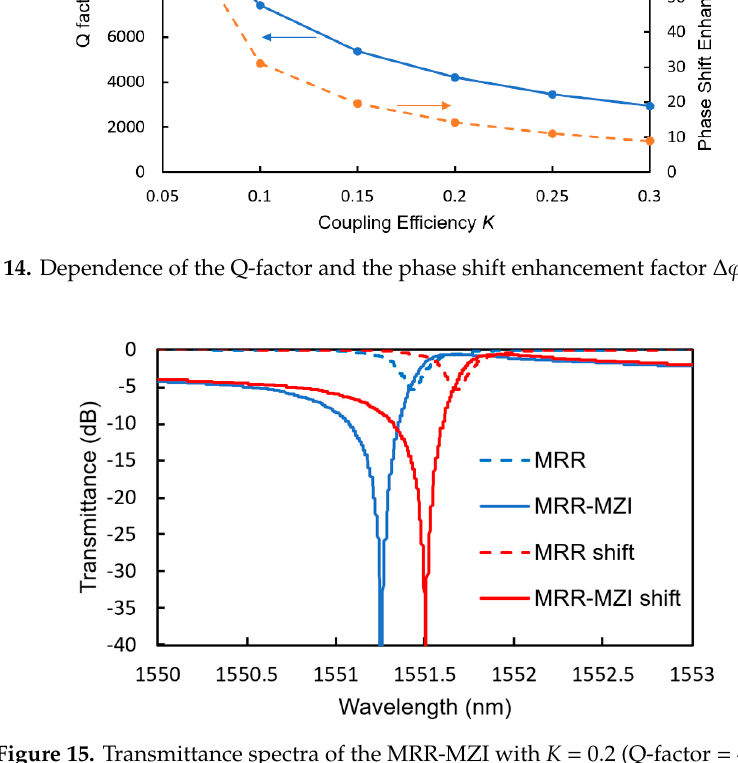
Figure 15. Transmittance spectra of the MRR-MZI with K = 0.2 (Q-factor = 4220).